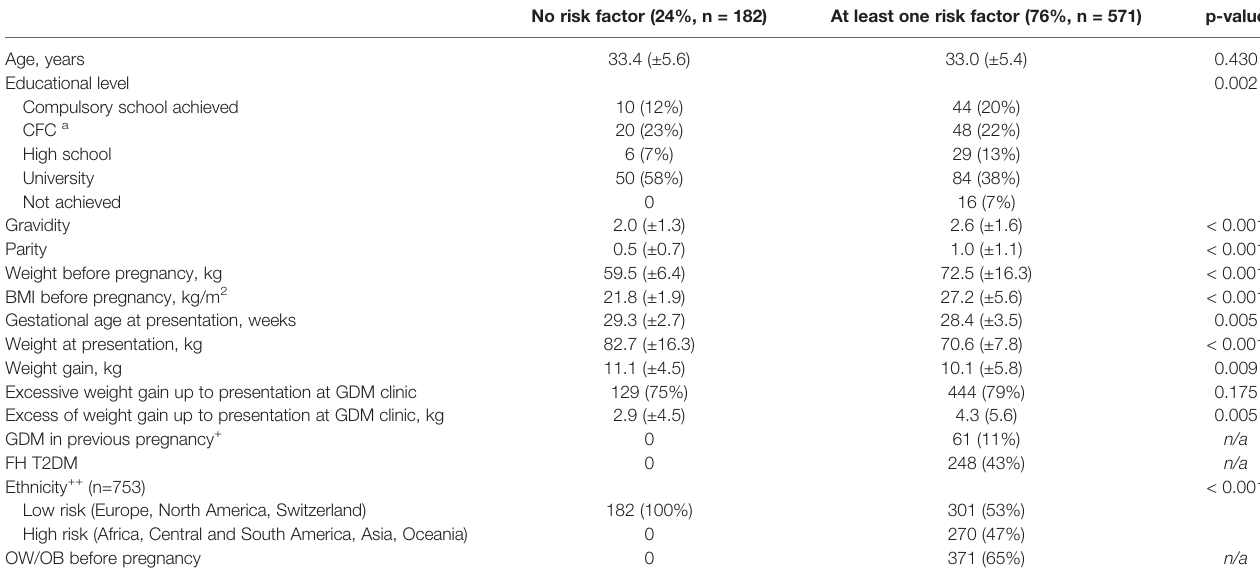
TABLE 1 | Descriptive characteristics of patients before pregnancy or at